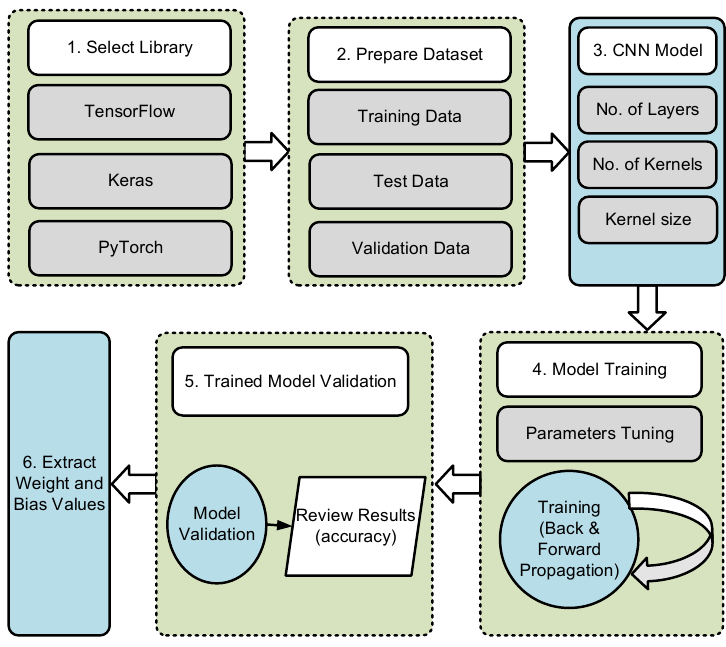
Figure 3. Implementation flow of the proposed CNN engine.